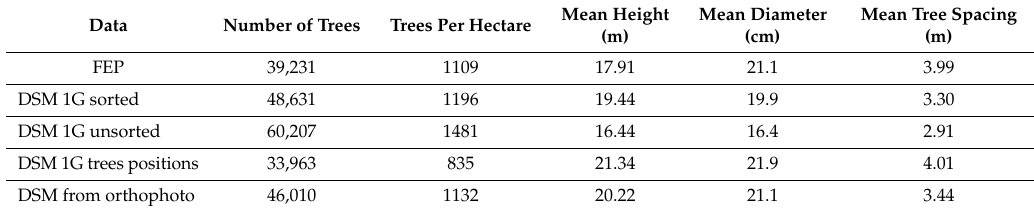
Table 3. Characteristics of the Forest Baˇcet í n representing each tested